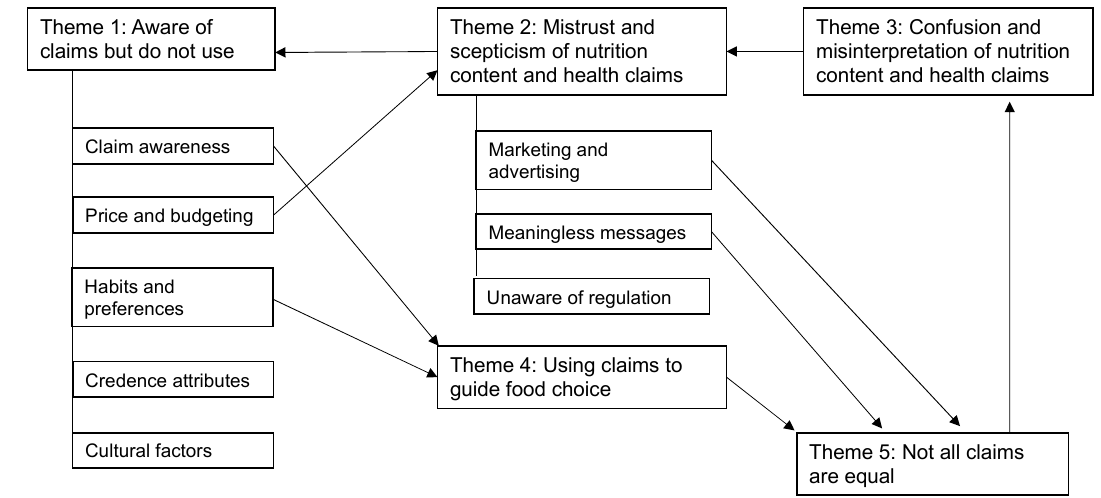
Figure 1. Thematic map.